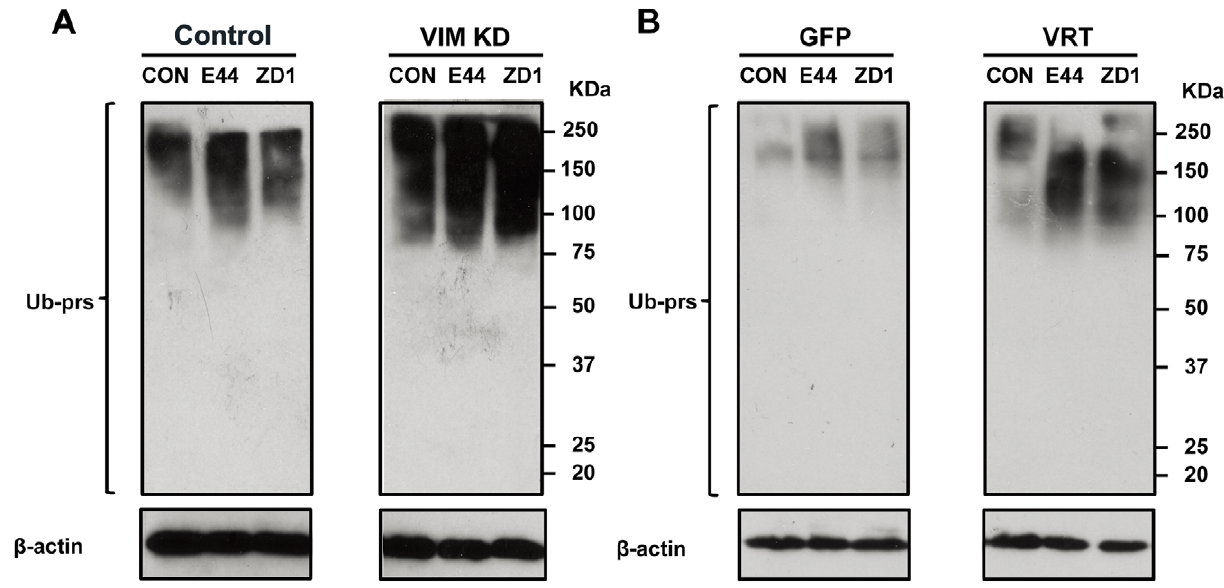
Figure 8. Inhibition of IbeA + E.coli K1-induced proteasomal degradation by knockdown of vimentin and VH domain deletion. Immunoblotting analysis of polyubiquitinylated proteins (Ub-prs): ( A ) HBMECs with siRNA-mediated knockdown of vimentin; and ( B ) HBMECs transduced with the lentivirus constructs expressing GFP–VRT and GFP. In both (A) and (B), all the cells were incubated with or without E. coli K1 strains (E44 and ZD1, 10 7 /ml) for 2 h. The Ub-prs were detected in cytoplasmic fractions to determine the proteasomal degradation as described in Materials and Methods. b -actin was used as an internal loading control. In all experiments, untreated HBMECs (UNT) were taken as controls.